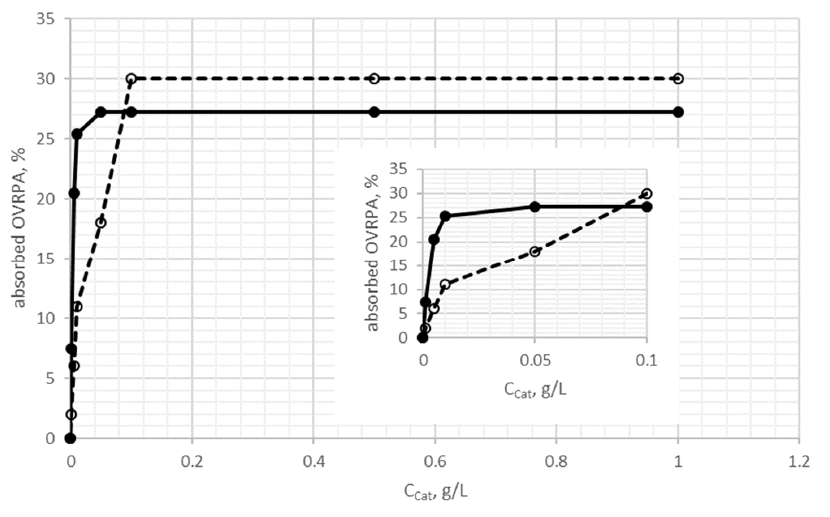
Figure 5. Percentage of absorbed radiation with catalyst concentration from the SFM model ( ) and the Monte Carlo method (percentages values from these method deduced from [21] ( ).